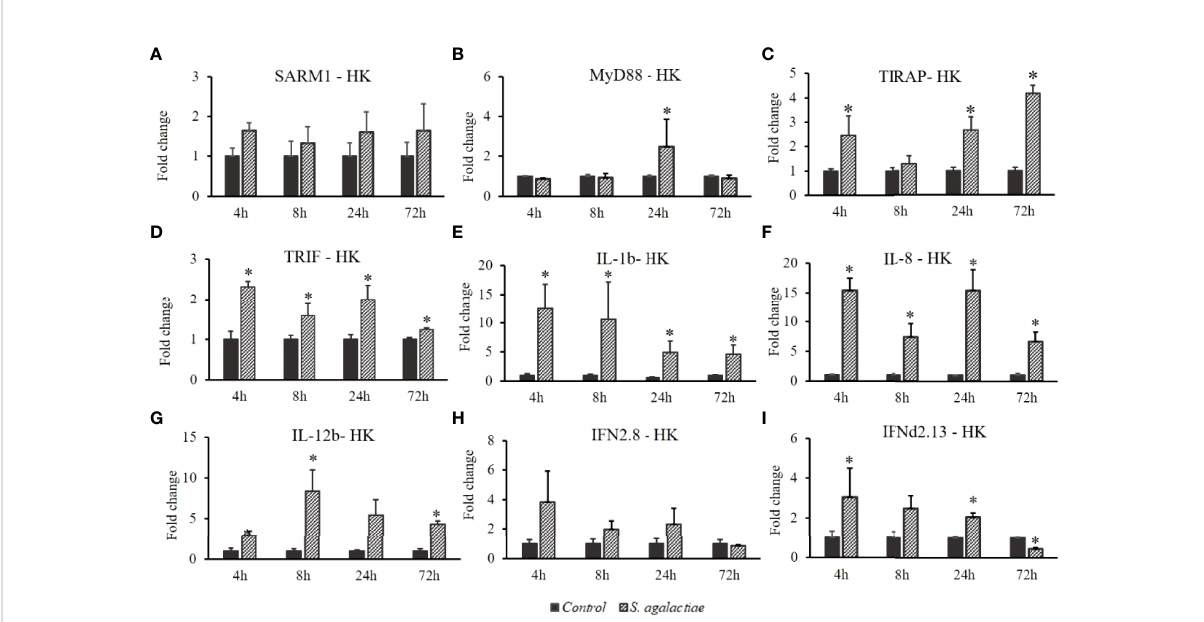
FIGURE 7 Gene expression of (A) SARM1 , (B) MyD88 , (C) TIRAP , (D) TRIF , (E) IL-1 b , (F) IL-8 , (G) IL-12b , ( H ) IFNd2.8 , and (I) IFNd2.13 in the head kidney from Oreochromis niloticus challenged with Streptococcus agalactiae . Expression of the indicated genes was normalized to the expression level of EF-1 a and expressed as fold change relative to the control group. The values are shown as mean + SD (n = 3). Signi fi cant differences from the control group at each time point are indicated by asterisks (P < 0.05, unpaired sample t-test).